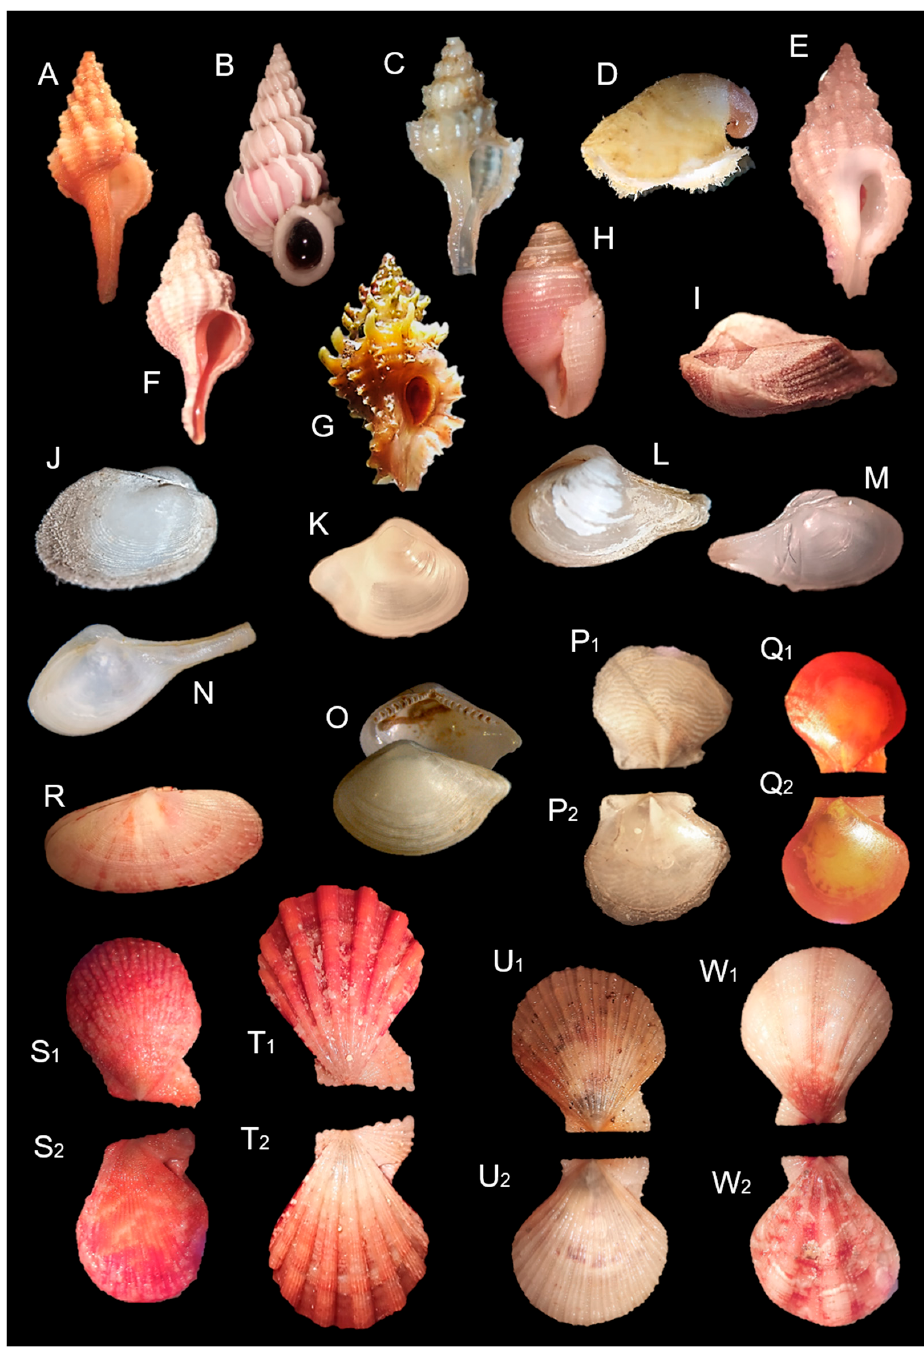
Figure 2. Some molluscans species collected from Ses Olives, Ausias March and Emile Baudot seamounts in the Mallorca Channel (Balearic Islands): ( A ) Fusinus pulchellus ; ( B ) Epitonium celesti ; ( C ) Pagodula echinata ; ( D ) Capulus ungaricus ; ( E ) Orania fusulus ; ( F ) Trophonopsis muricata ; ( G ) Murexul aradasii ; ( H ) Japonacteon pusillus ; ( I ) Tetrarca tetragona ; ( J ) Bathyarca philippiana ; ( K ) Tropydomia abbreviata ; ( L ) Cuspidaria cuspidata ; ( M ) Cardiomya costellata; ( N ) Cuspidaria rostrata ; ( O ) Ledella messanensis ; ( P ) Similipecten similis ; ( Q 1 , Q 2 ) Palliolum incomparabile ; ( R ) Gari costellata ; ( S 1 , S 2 ) Tolochlamys multistriata ; ( T 1 , T 2 ) Manupecten pesfelis ; ( U 1 , U 2 ) Karnekampia sulcata ; and ( W 1 - W 2 ) Pseudamussium clavatum . Images not to scale.